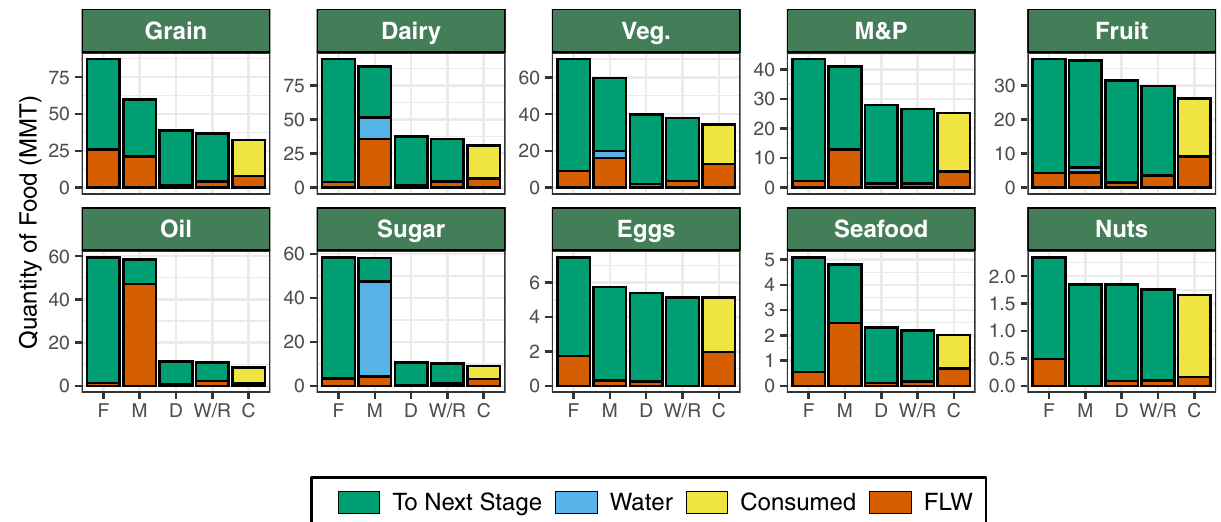
Fig. 2 Food commodities ’ contribution to FLW in different stages of the FSC. Detailing the food products/agricultural materials ’ fl ow to the next stage (green) or water evaporated during food manufacturing process (Water, blue), consumed (yellow), or as FLW (vermillion). The 10 commodities are represented with their own labeled panel (M&P represents meat and poultry, and Veg. represents vegetables) and each stage is a different column (on- farm production [F], food manufacturing [M], distribution [D], wholesale & retail [W/R], consumption [C]). The y -axes labels vary between panels so mass fl ow details are more visible.